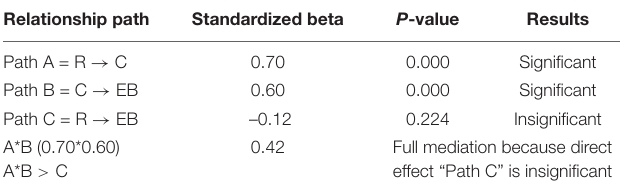
TABLE 4 | Mediation analyses with DV1.